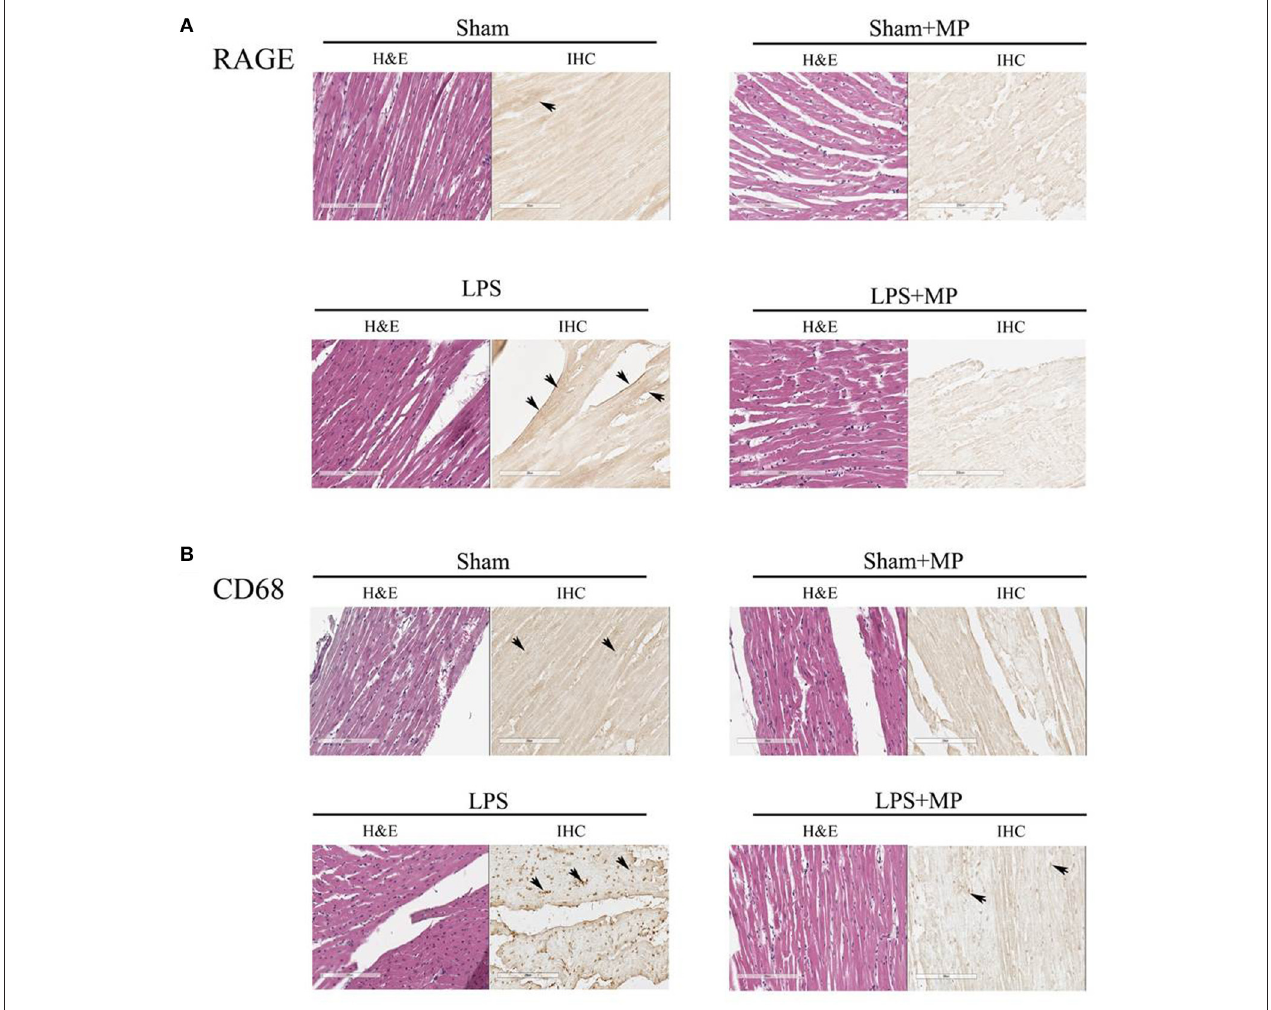
FIGURE 3 | Effects of LPS and MP on the expression of CD68 (macrophage marker) (A) and RAGE (inflammatory marker) (B) in the myocardium. We used the immunohistochemical staining technique to probe CD68 (400x) and RAGE (400x) expressions at the cardiac tissues. The sites of antibody staining were indicated by arrows. LPS, lipopolysaccharide; MP, methylprednisolone; RAGE, receptor for advanced glycation end